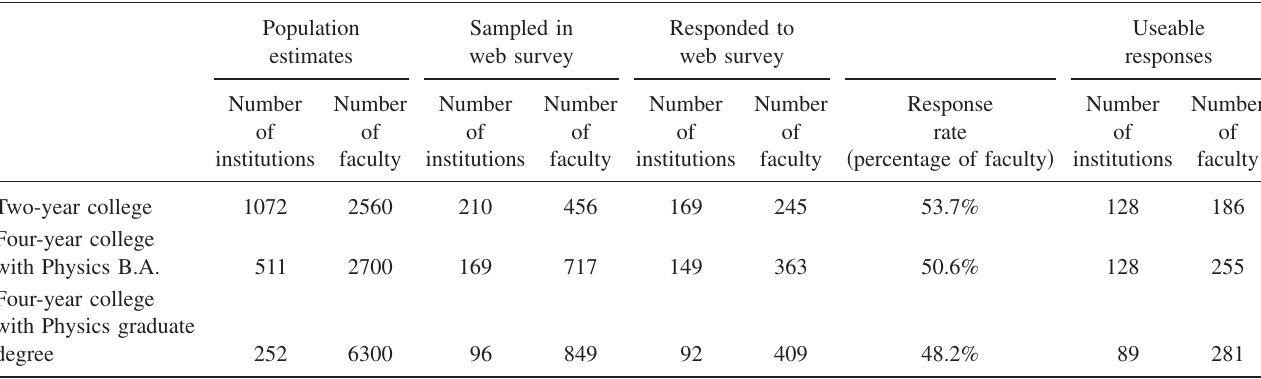
TABLE I. Overview of population, sampled survey participants, and web survey response rates for faculty in each type of institution. Population estimates are from reports by the AIP Statistical Research Center.